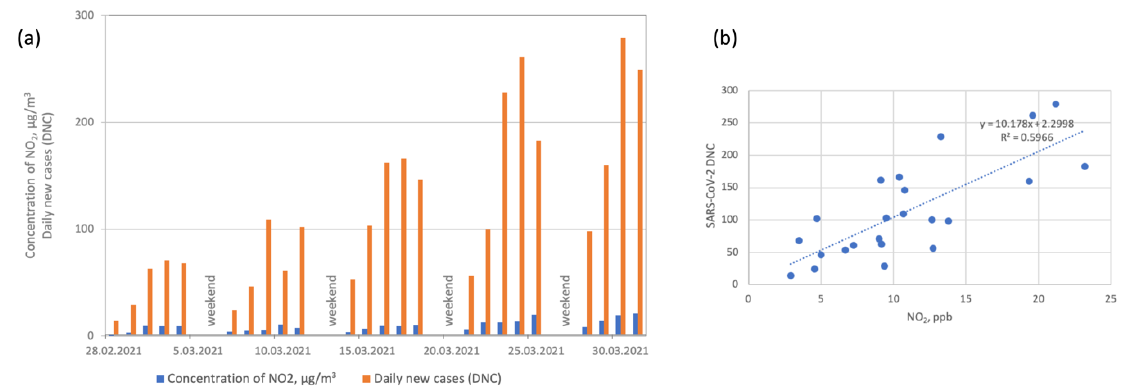
Figure 7. ( a ) NO 2 concentrations and SARS-CoV-2 daily new cases (DNCs). ( b ) Linear regression coefficients between NO 2 concentrations and SARS-CoV-2 daily new cases (DNCs).